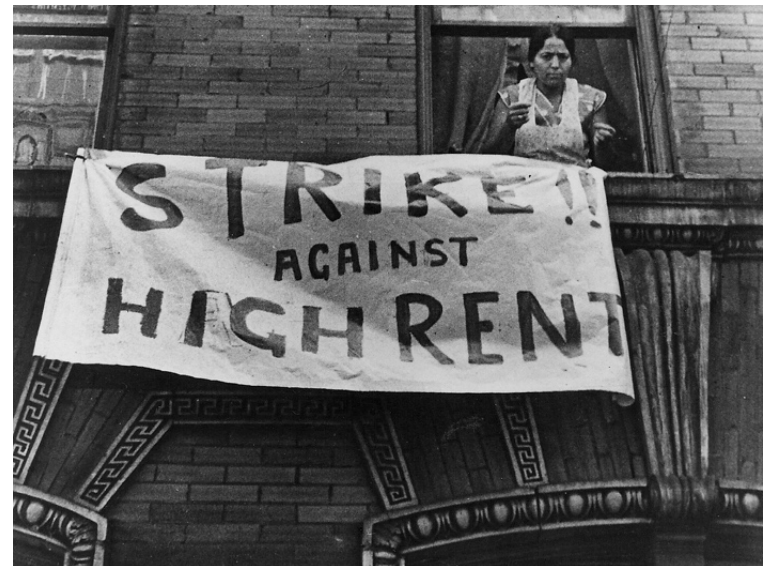
Figure 5. Leo Seltzer, ‘Rent Strike, Upper East Side, New York City’, 1933, gelatin silver print. © Leo Seltzer.